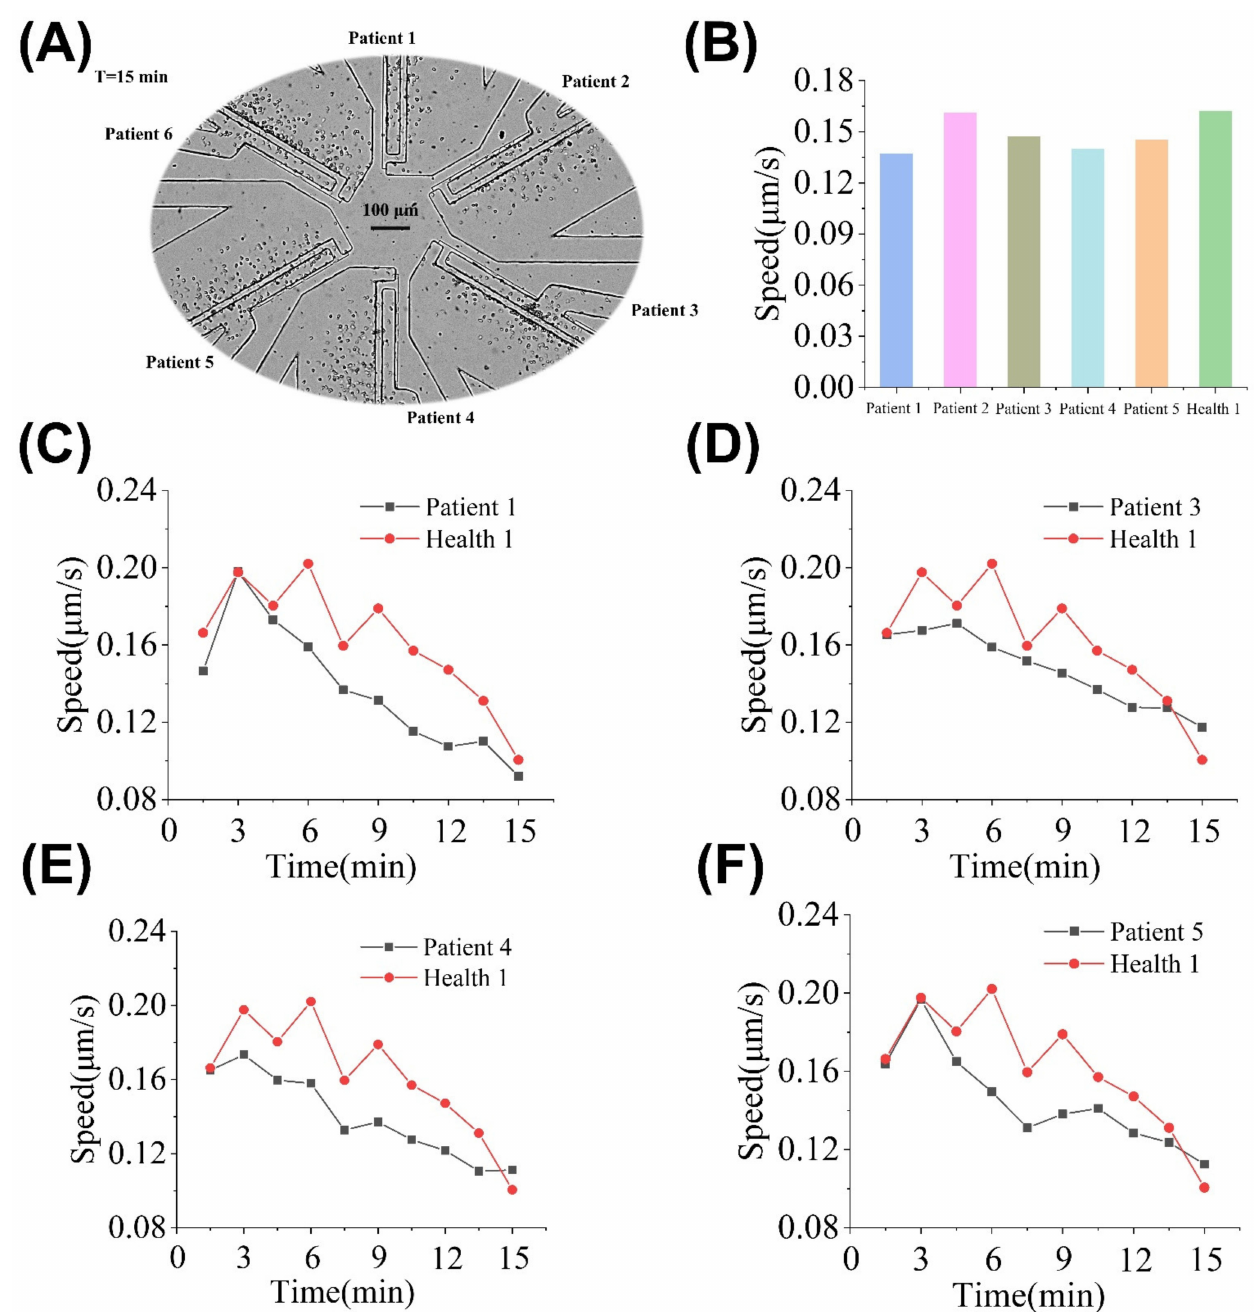
Figure 8. Neutrophil chemotaxis of TD2M patients (n = 5) and healthy person (n = 1). ( A ) Experiment setup and images in the SC 2 chip after 15 min. ( B ) Average V values of healthy 1 and five TD2M patients. ( C ) Time-dependent V values of neutrophils of healthy 1 and TD2M patient 1. ( D ) Time- dependent V values of neutrophils of healthy 1 and TD2M patient 3. ( E ) Time-dependent V values of neutrophils of healthy 1 and TD2M patient 4. ( F ) Time-dependent V values of neutrophils of healthy 1 and TD2M patient